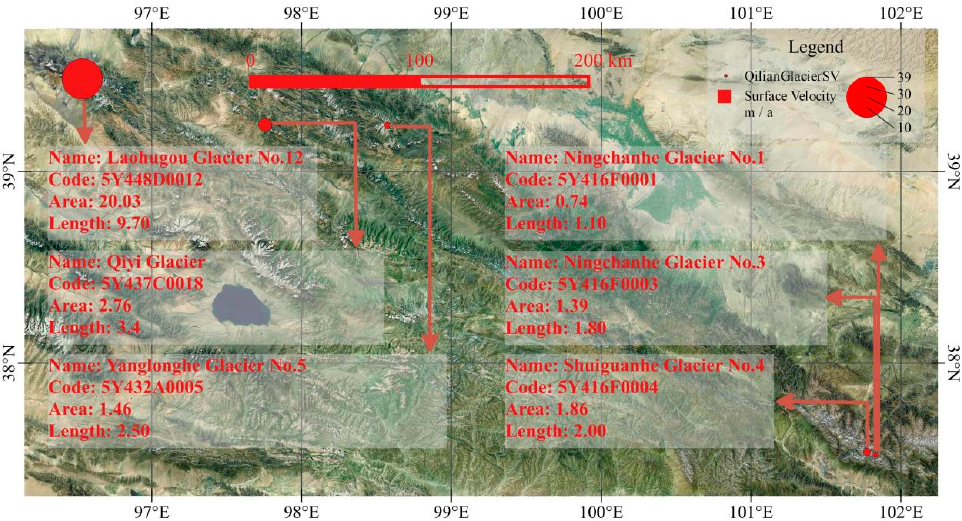
Figure 12. Surface velocity of glaciers in the Qilian Mountains (Laohugou glacier No.12, Qiyi Glacier [52,53], Yanglonghe Glacier No.5 [50,52], Shuiguanhe Glacier No.4 [54], Ningchanhe Glacier No.3 [55], Ningchanhe Glacier No.1 [56]).